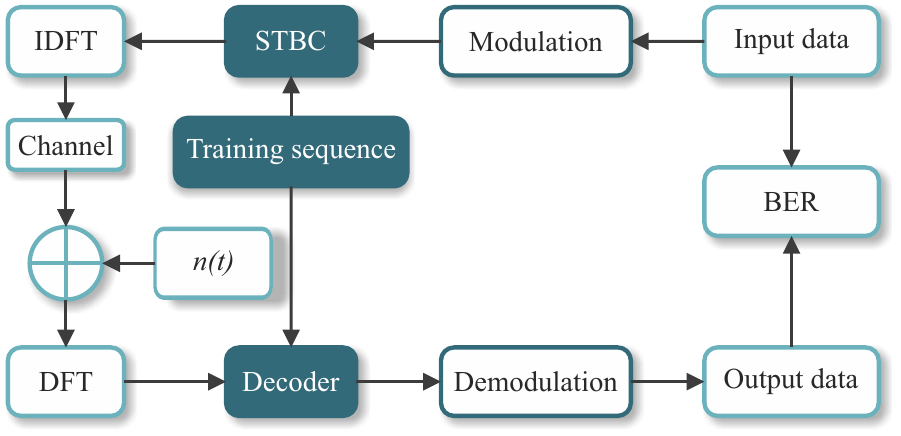
Figure 7. Block model of the simulated